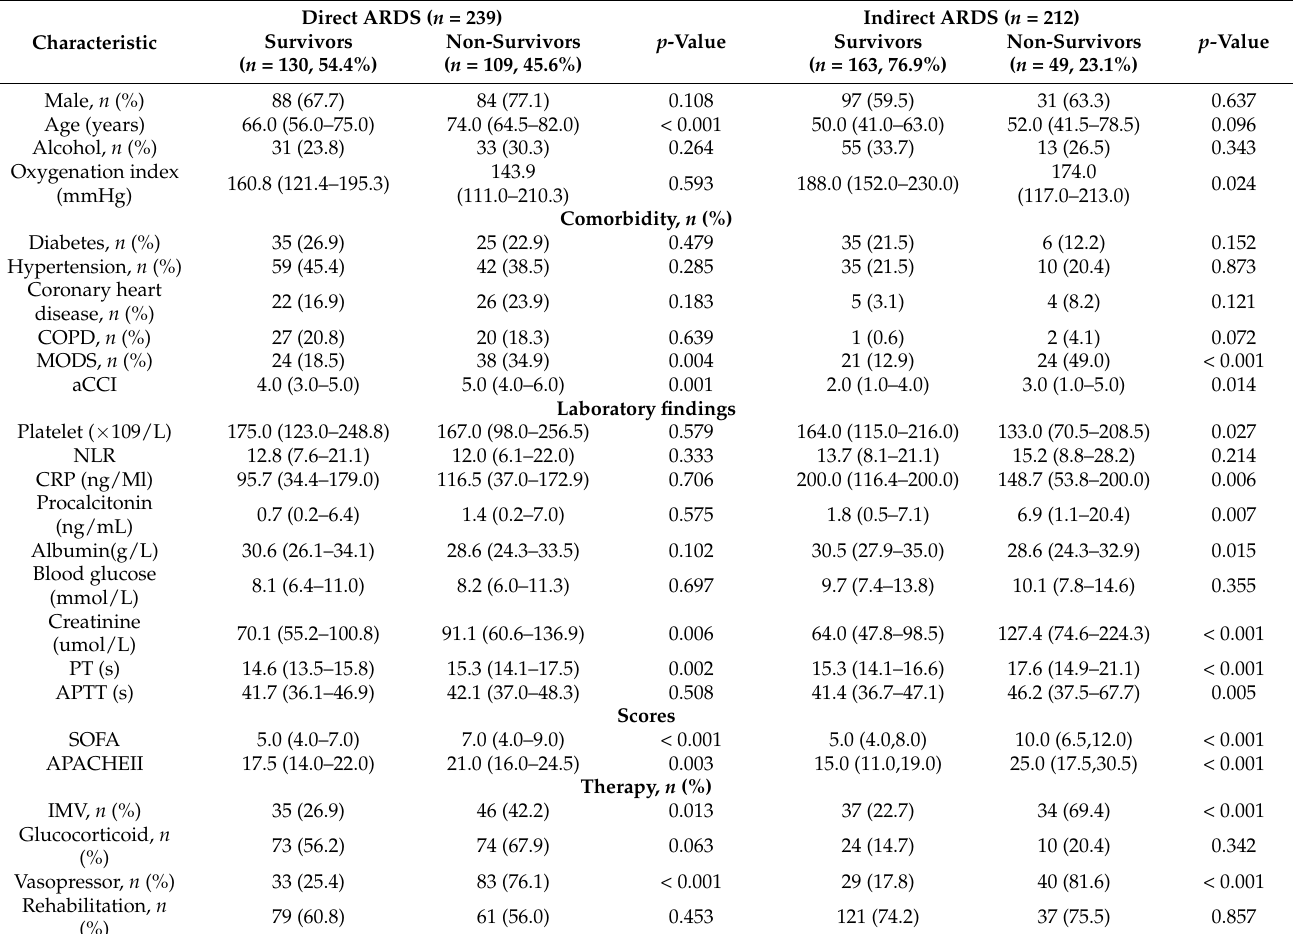
Table 2. Clinical characteristics of the survivors and